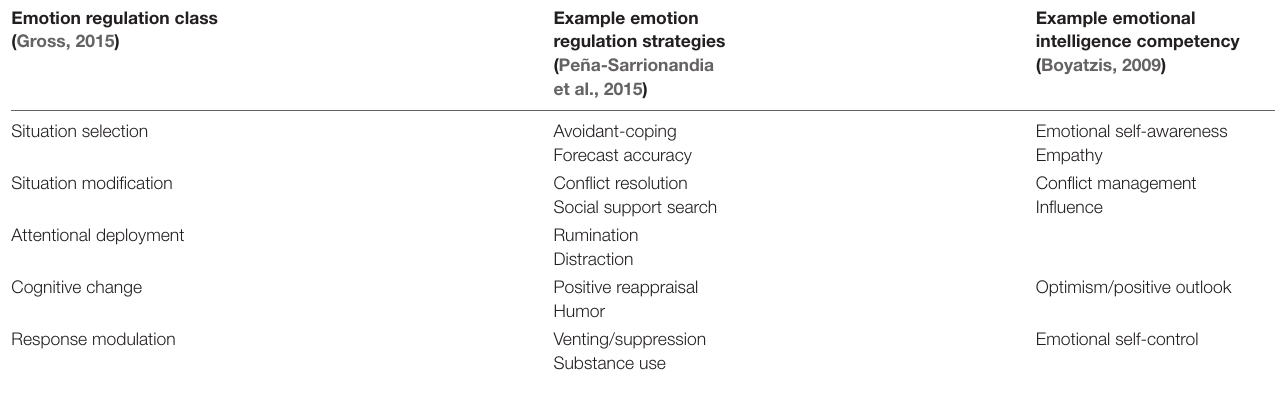
TABLE 2 | Overlaps between emotion regulation classes, emotion regulation strategies, and outcomes currently considered to be emotional intelligence competencies. Emotion regulation class (Gross,